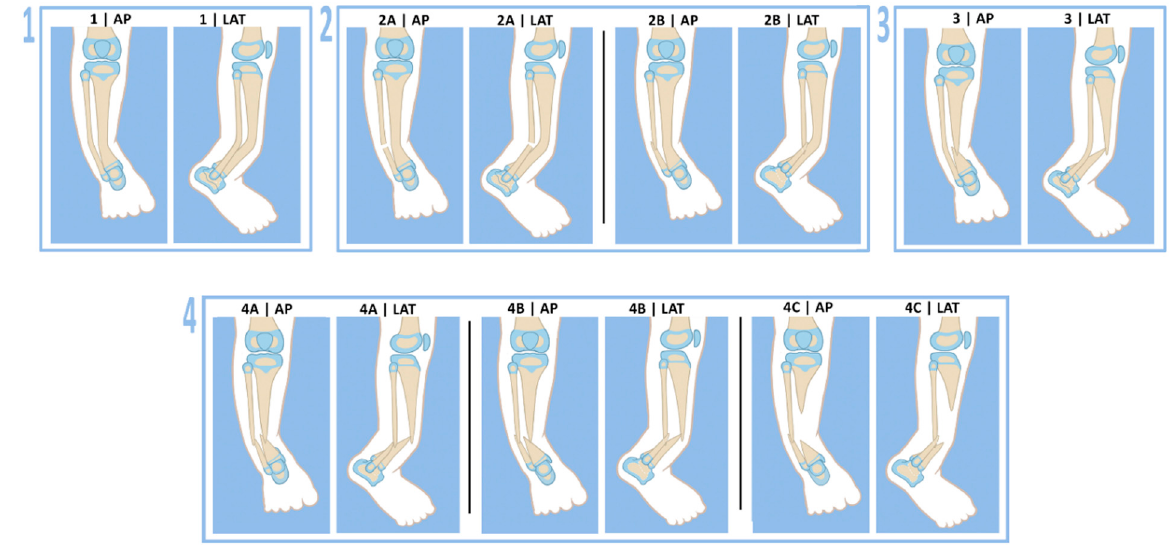
Figure 2. The Paley classification of CPT: ( 1 ) intact tibia and fibula with anterolateral bow; ( 2A ) intact tibia with broken fibula remaining at station; ( 2B ) intact tibia with broken fibula that has proximally migrated; ( 3 ) Intact fibula with broken tibia; ( 4A ) Broken tibia and fibula with fibula remaining at station; ( 4B ) broken tibia and fibula with proximal migration of fibula; ( 4C ) broken tibia and fibula with significant bone defect.